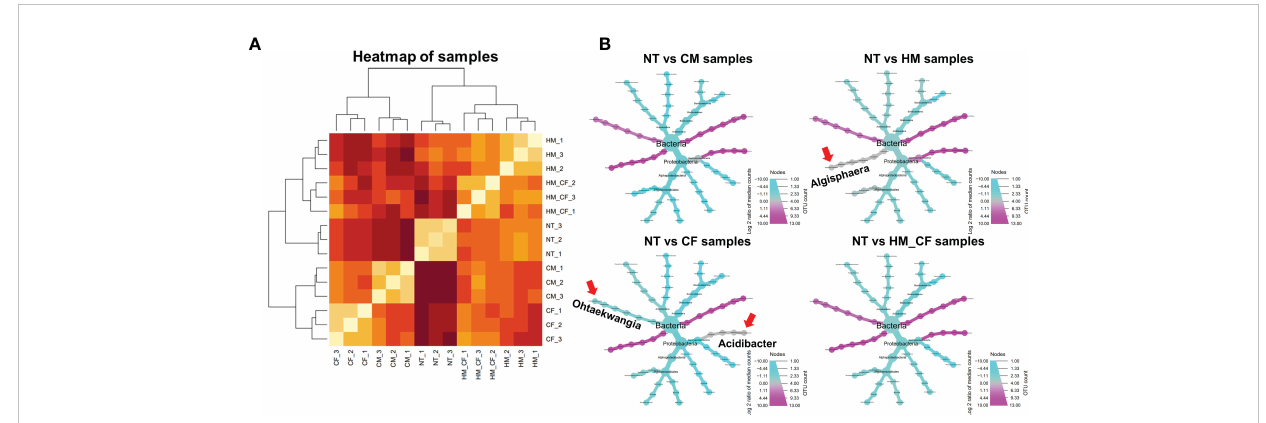
FIGURE 6 Taxonomic composition of signi fi cant bacteria analysis in the soils after different fertilizer supplies (NT, non-treatment; CM, commercial manure; HM, Hanwoo manure; CF, chemical fertilizer; HM+CF, combined use of Hanwoo manure and chemical fertilizer). (A) Hierarchical clustering of samples with signi fi cant bacteria. The line colors represent the different levels of beta diversity by using Bray − Curtis dissimilarity. (B) The relative abundances of signi fi cantly correlated bacteria in NT, CM, HM, CF, and HM+CF groups compared to the NT group. Circle size represents the number of bacteria for ASV. The color indicates the log 2-fold change of ASV with p-adjust < 0.05. Arrow represents the speci fi c bacteria in each